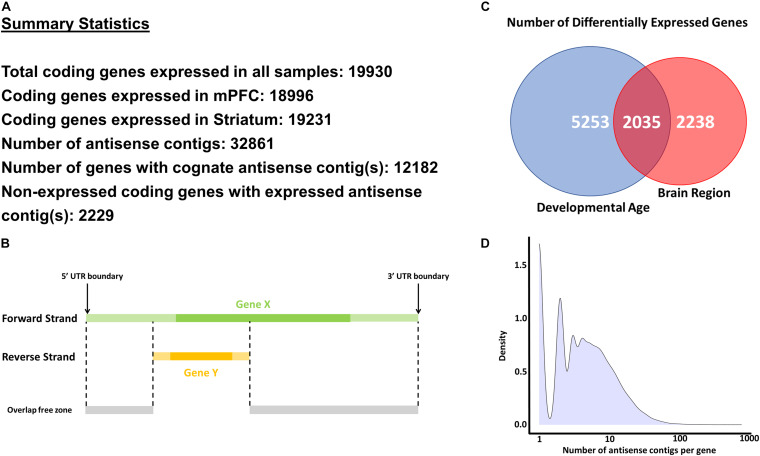
Methodology and key statistics for the current study. (A) Summary statistics for the main analyses conducted in the study. (B) A schematic explaining the methodology to extract antisense reads for a selected gene (Gene X). Only antisense reads in the overlap free zone were used in analyses. (C) Number of differentially expressed genes across developmental age and brain regions. (D) Histogram of number of antisense contigs per gene.